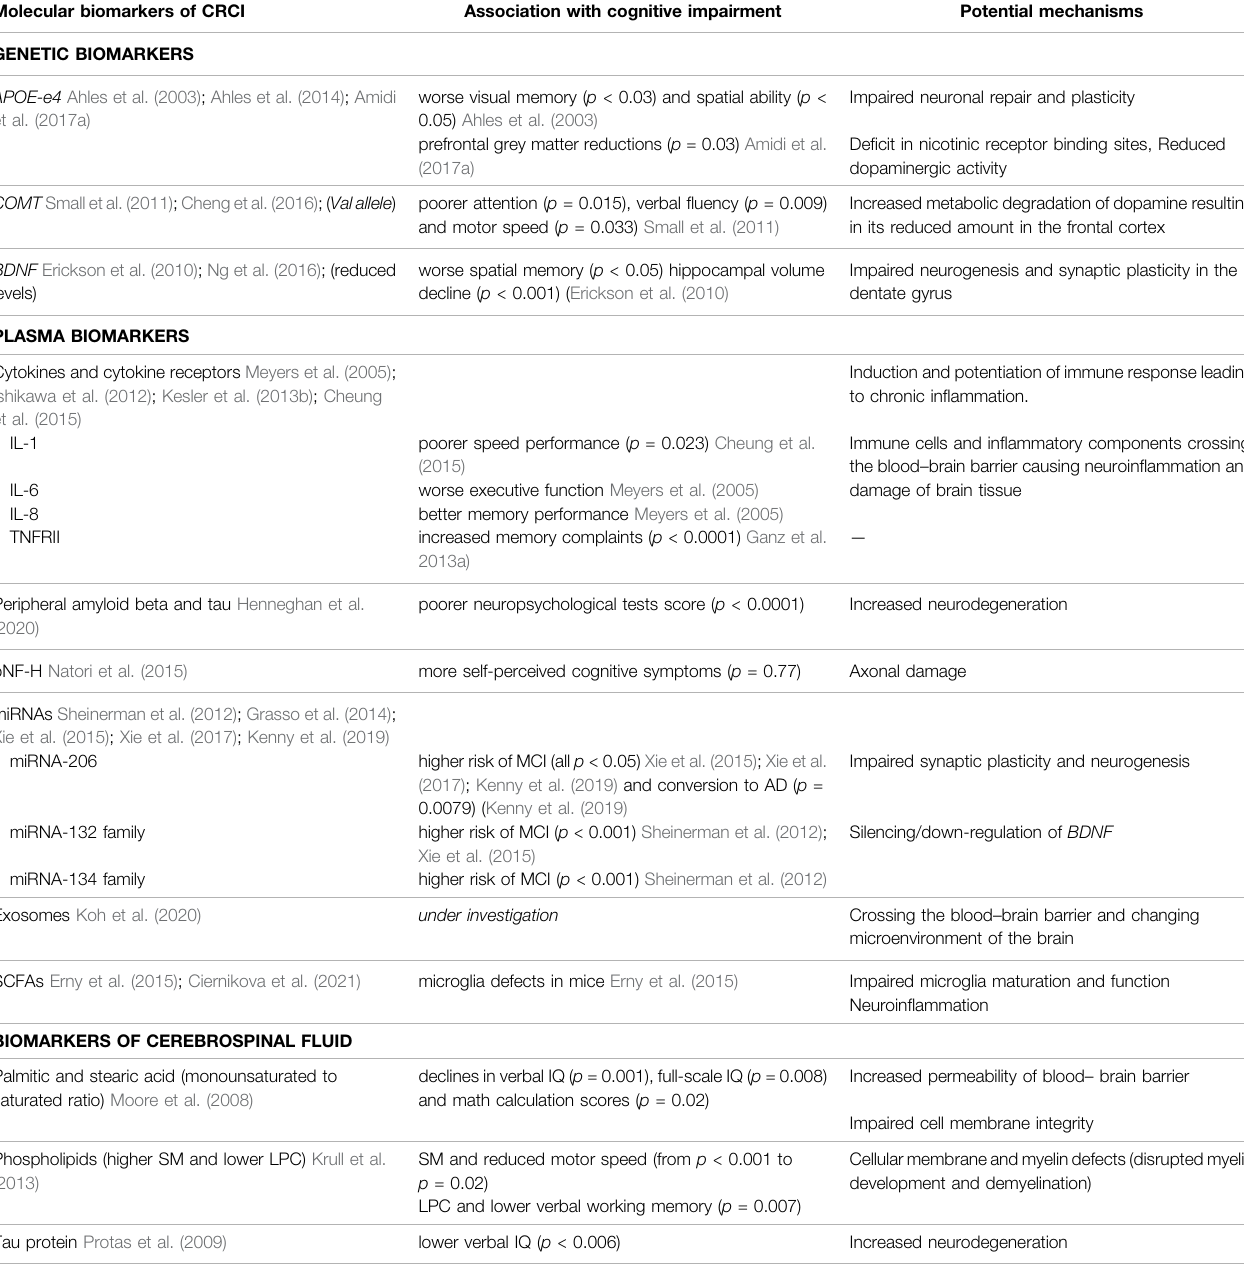
TABLE 2 | Molecular biomarkers of CRCI with potential mechanisms of the development of cognitive dysfunction in cancer patients. Molecular biomarkers of CRCI Association with cognitive impairment Potential